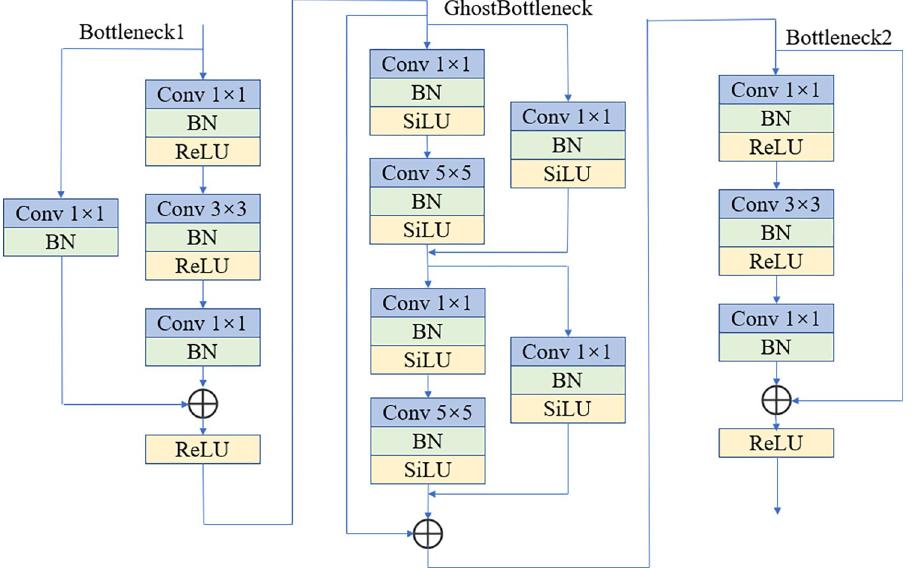
Fig 4. The GhostBottleneck structure used in the